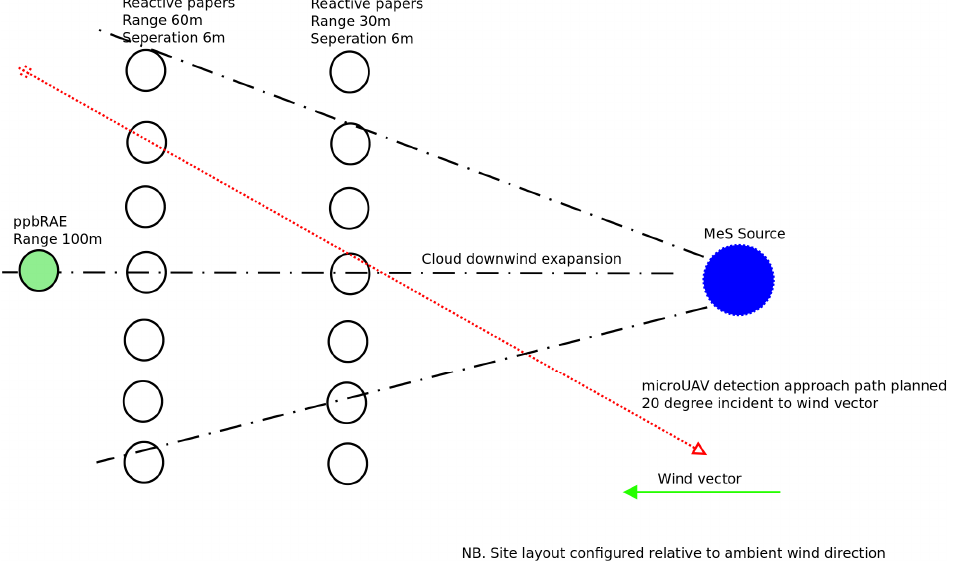
Figure 2. EFT Site layout.